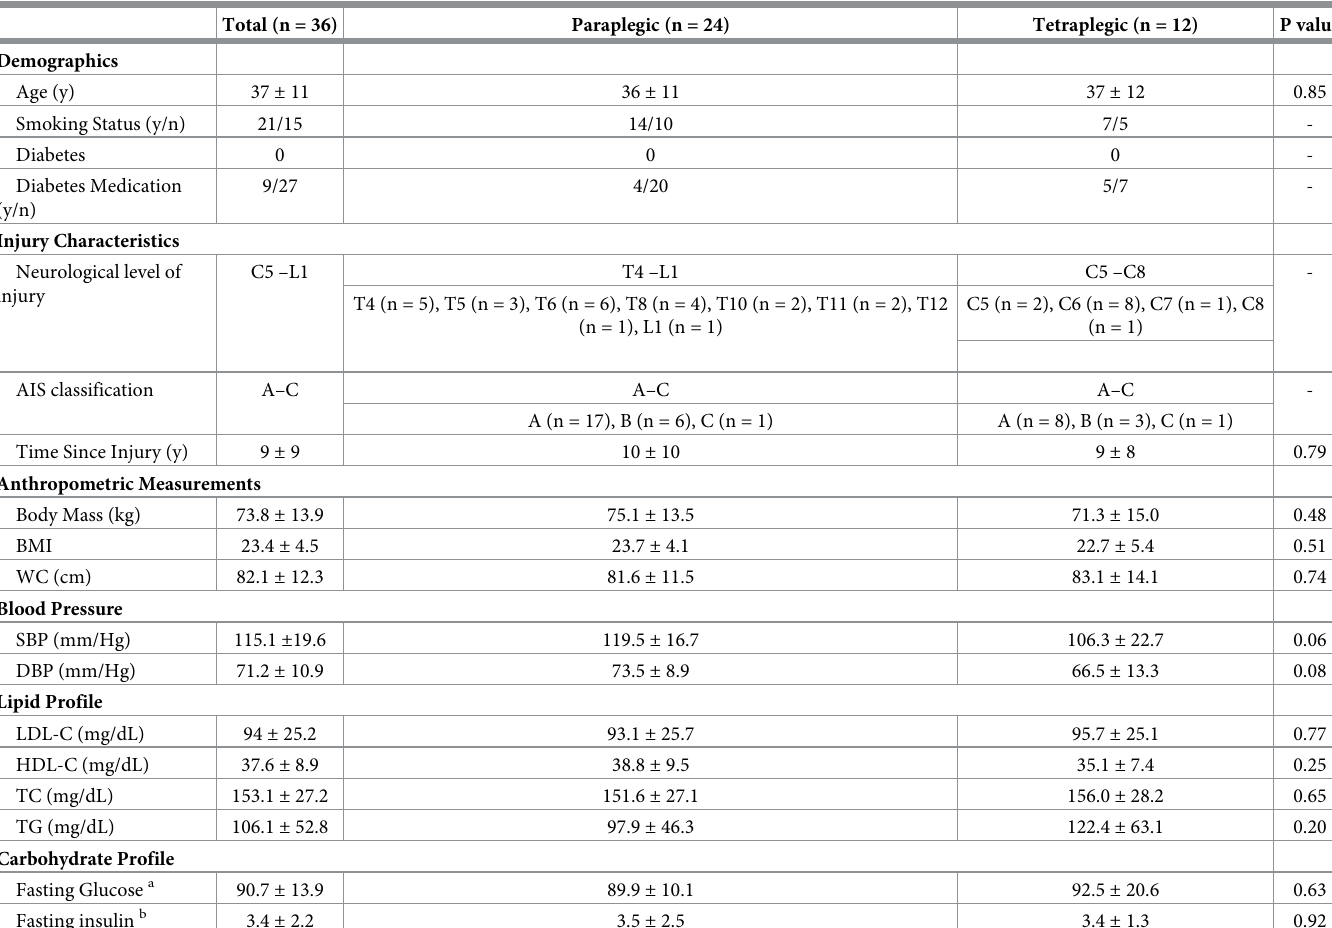
Table 2. Physical characteristics and metabolic profile of all participants enrolled in the current